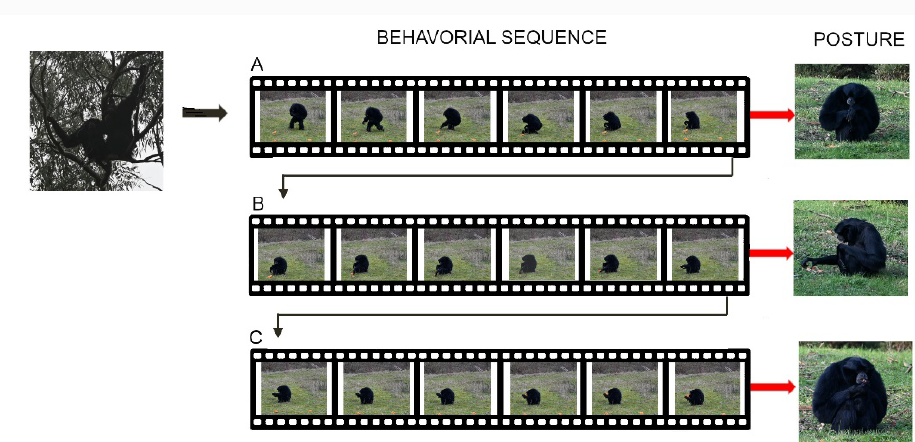
Figure 7. Sitting posture to reach the food ( A ), grasp it ( B ), and feed ( C ) in Symphalangus syndactylus result from the integration of combined motor actions (movements) of the axial, and appendicular systems (i.e., limb and hand) that are determined by analysis of animal sequences. The final posture of each behavior corresponds to the end of a sequence of movements of the whole body and/or one of its components under different motor controls.